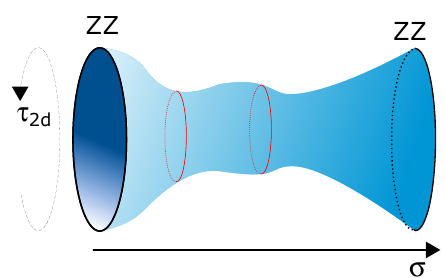
Figure 12 . Liouville ZZ-brane system with a varying circular circumference T ( (cid:27) ) for the angular coordinate (cid:28) 2 d (cid:24) (cid:28) 2 d + T ( (cid:27)